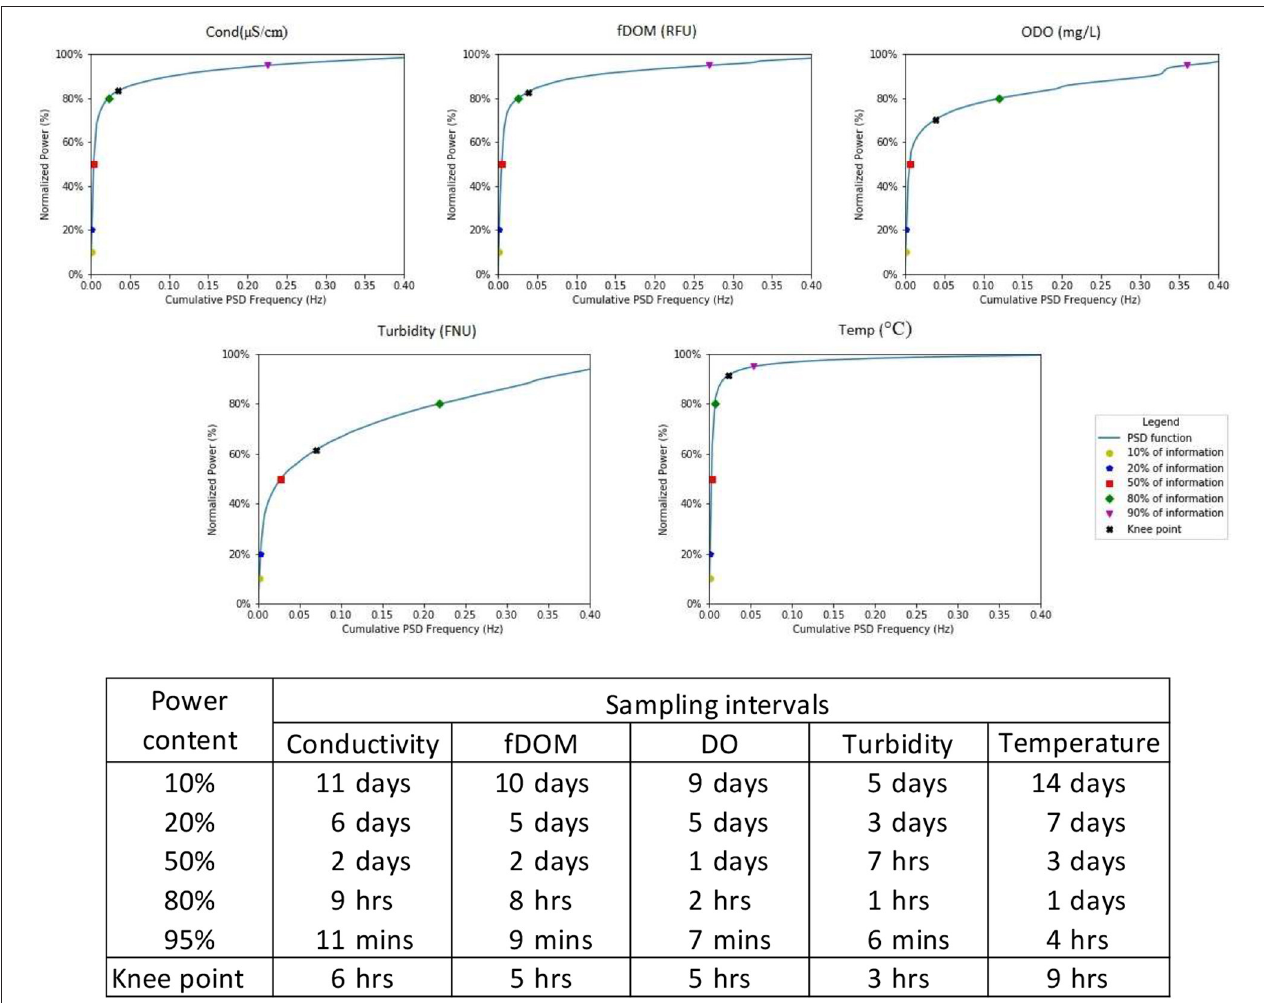
FIGURE 4 | Cumulation PSD plots using the worst-case scenario dataset. The values for the points marked on the plots are shown in the table. The accumulated frequency shows the quantity of information that will be collected with a specific sampling interval for a water quality